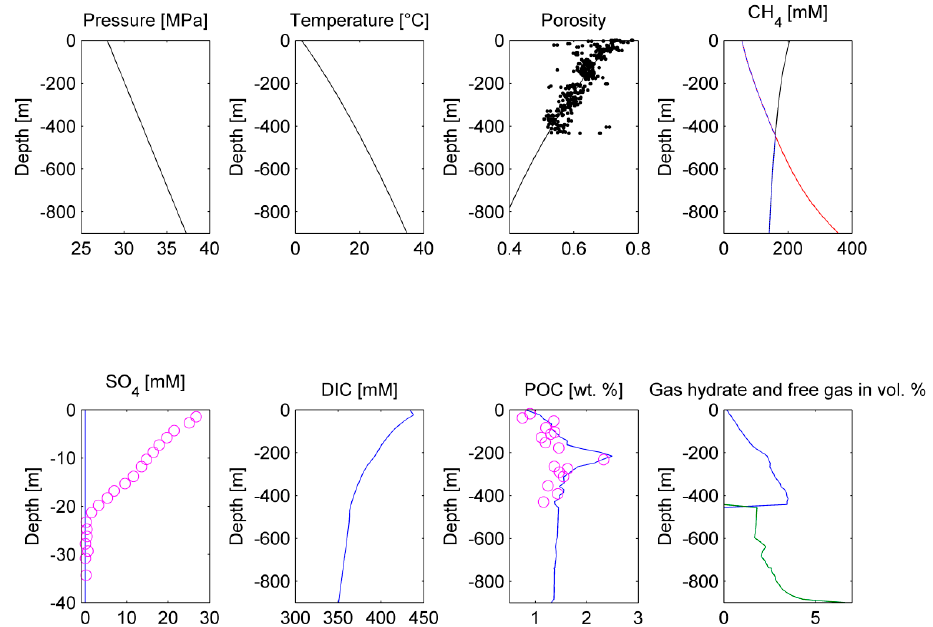
Figure 9. Modeling results of the Scenario 5. Upper panel, from the left: Pressure, temperature, porosity, and dissolved CH 4 concentration plots. Porosity measurements [20] are depicted as black dots, the modeling solution is represented by the black line. On the CH 4 concentration plot, red line depicts the phase boundary between gas hydrate and dissolved methane, black line represents the phase boundary between free gas and dissolved methane, blue line states dissolved methane concentration. Gas hydrate and / or free gas formation occurs wherever dissolved methane concentration exceeds one of the solubility curves. Lower panel, from the left: SO 4 , DIC, POC, and gas hydrate / free gas concentration plots (in blue and green, respectively). On the SO 4 and POC concentration plot, measured values are presented as pink circles [20], whereas model predictions are shown as the blue lines.